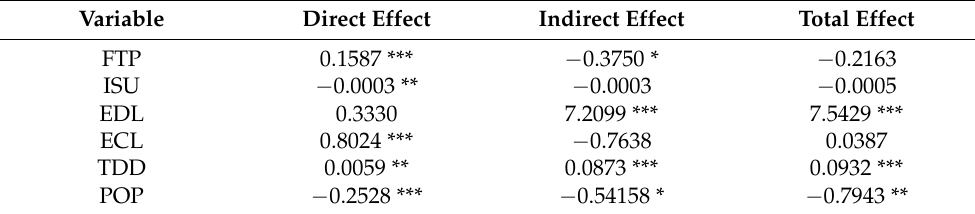
Table 7. Marginal effect decomposition of spatial Durbin